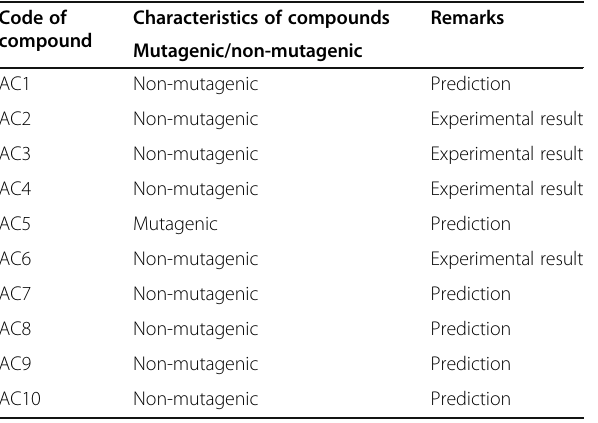
Table 8 Mutagenic property of compounds of fermented Allium cepa peel methanolic extract Code of